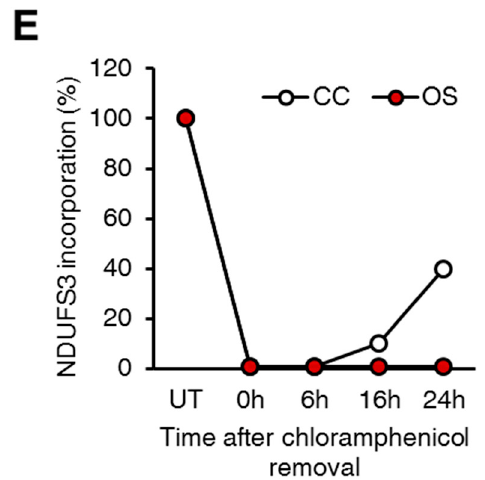
Figure 1. Human ND1 is necessary for CI assembly and stability. ( A ) Immunoblotting of ND1 levels in crude mitochondria obtained from control (CC) and three different ND1-null cybrids (OS). One representative experiment of three is shown. Complex I In-Gel Activity (CI-IGA) and western blot analysis of isolated CI using an antibody against the NDUFA9 subunit performed on isolated respiratory complexes separated by hrCNE. VDAC1 was used as a loading control. ( B ) 2D BN/SDS-PAGE performed on mitochondria-enriched fractions obtained from control (CC), three different ND1-null (OS) and mtDNA depleted (Rho 0) cybrids followed by western blot analysis using an antibody against NDUFS3. Fully assembled CI and sub-complexes (Sb1-2-3) are indicated by dotted lines. ( C ) 2D BN/SDS-PAGE followed by western blotting using an antibody against NDUFS3. Mitochondria-enriched fractions were obtained from control (CC) and three different ND1-null (OS) cybrids in absence (untreated, UT) of 50 µ g/mL chloramphenicol and at different times (0, 6, 16 and 24 h) after chloramphenicol removal. Fully assembled CI and sub-complexes (Sb1-2-3) are indicated by dotted lines. One representative experiment of three is shown. ( D ) 2D BN/SDS-PAGE, followed by western blotting using an antibody against SDHA, carried out in mitochondria-enriched fractions isolated from CC and OS clone in the absence (untreated, UT) of 50 µ g/mL chloramphenicol and at different times (0, 6, 16 and 24 h) after chloramphenicol removal. Fully assembled CII is indicated by dotted lines. One representative experiment of three is shown. ( E ) Mean incorporation rates of NDUFS3 in fully assembled CI after chloramphenicol removal. The signal was quantified on the level of SDHA, a subunit of CII. Mean values are expressed as percentages relative to untreated cells (UT,